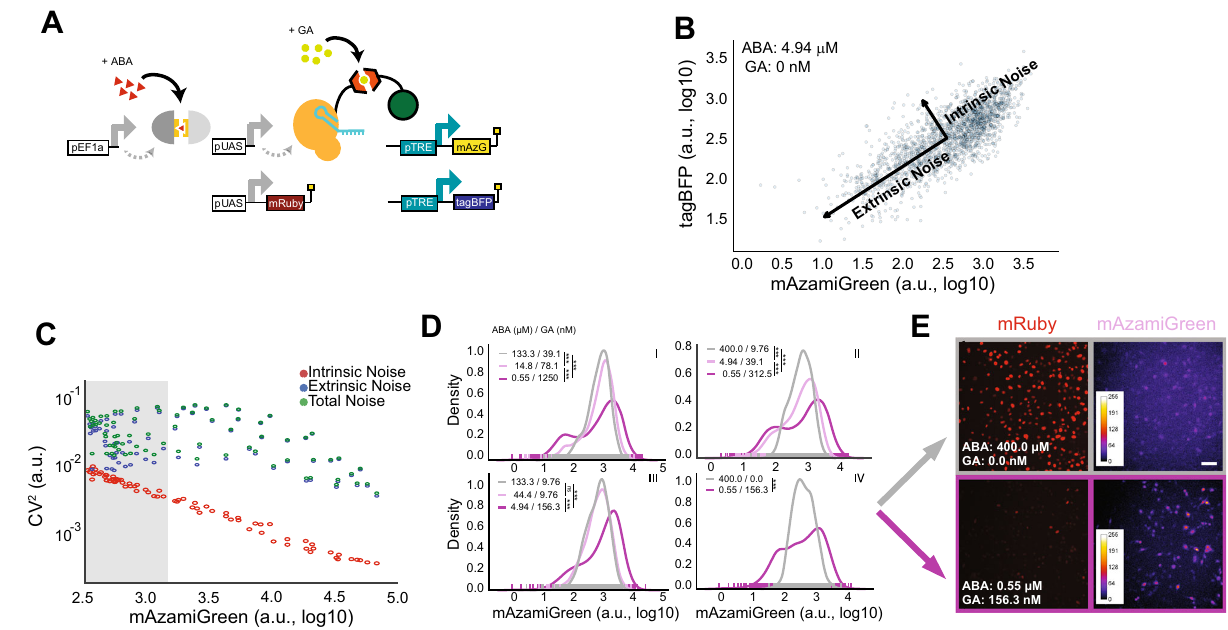
Fig. 2 TuNR confers independent control of population mean and variance in transgene expression. A Simpli fi ed diagram of TuNR shown in Fig. 1a, with the addition of pTRE driving expression of tagBFP in the same cell to decompose intrinsic and extrinsic noise. B Example scatter plot of tagBFP and mAzamiGreen expression from TuNR induced with 4.94 µ M ABA and 0 nM GA. Decomposition identi fi es two major axes of variance: intrinsic variance, which is the spread of points perpendicular to the diagonal; and extrinsic variance, represented by the spread of points along the diagonal. C Plot of intrinsic (red), extrinsic (blue), and total (green) noise, quanti fi ed using the coef fi cient of variation or CV 2 , vs. mean expression of mAzamiGreen of TuNR- containing cells exposed to different combinations of ABA and GA (each ABA/GA combination has an associated intrinsic, extrinsic and total noise value represented by a point). Shaded region represents example area of tunable noise, as demonstrated in D . D Representative kernel density distributions of mAzamiGreen expression for different combinations of inducer molecules, as identi fi ed in C (i, ii, iii, and iv), which achieve the same mean expression from one of two independent experiments. ***Padj <<<0.05; two-sided Kolmorgorov – Smirnov test (Bonferroni corrected), NS: not signi fi cant. Trace 1 (gray), trace 2 (light purple), and trace 3 (dark purple). (i) 1 : 2, p = 2.03E − 32; 1 : 3, p = 8.51E − 07; 2 : 3, p = 1.09E − 18. (ii) 1 : 2, p = 4.83E − 12; 1 : 3, p = 9.42E − 53; 2 : 3, p = 5.48E − 24. (iii) 1 : 2, NS; 1 : 3, p = 6.16E − 55; 2 : 3, p = 2.36E − 49. (iv) 1 : 3, p = 1.17E − 31. Scale bar, 50 µ m. E Representative images of mRuby expression and pseudo-colored mAzamiGreen expression from one of two independent clonal replicates corresponding to cells from the populations shown in D , isomean